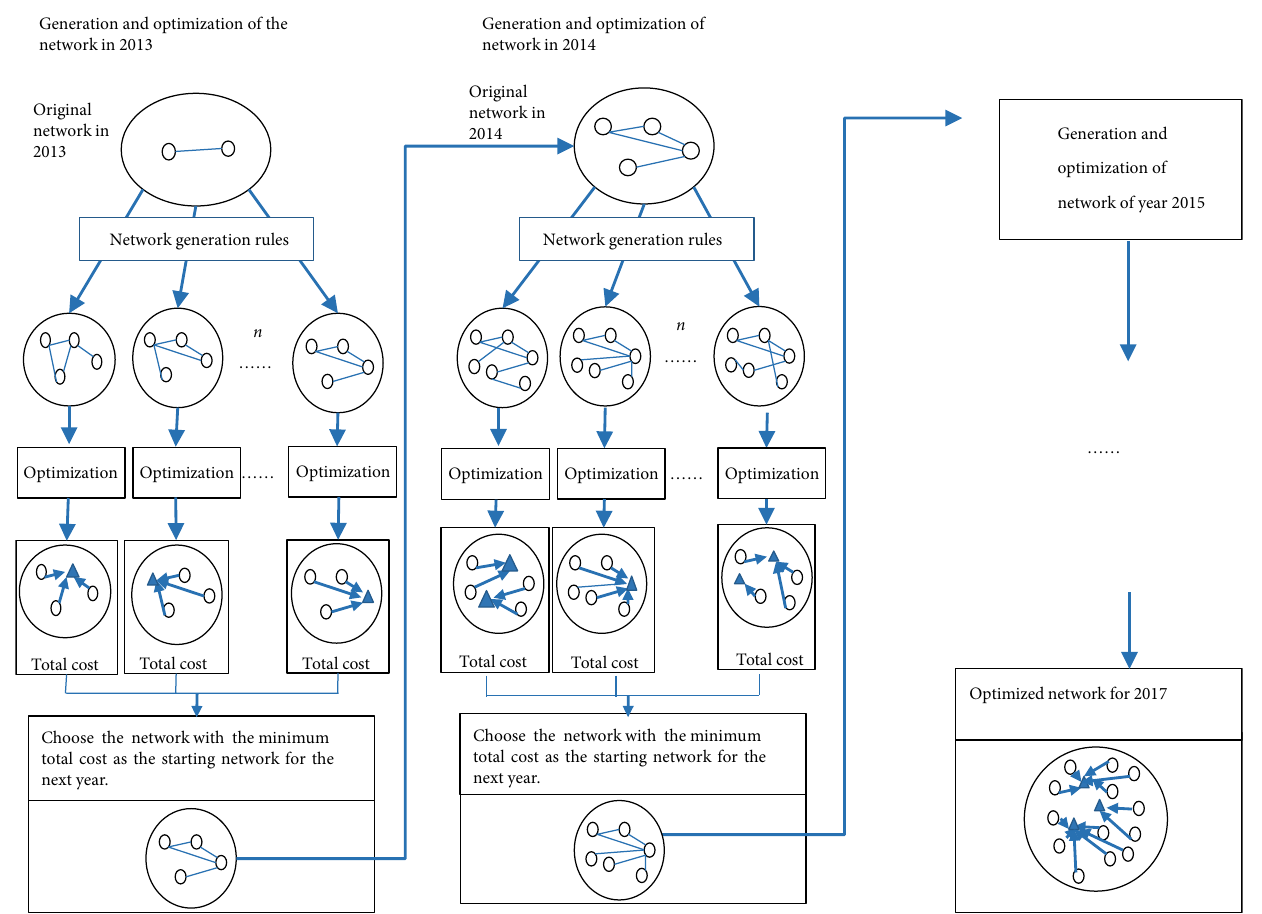
Figure 2: Framework for evolution of the transportation logistics